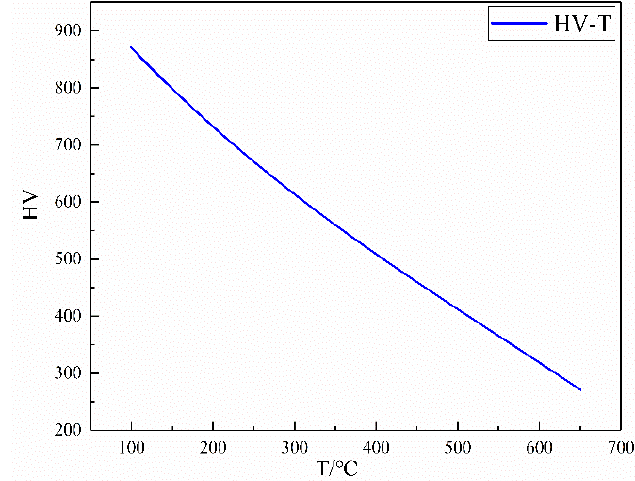
Figure 2. HV-T curve.